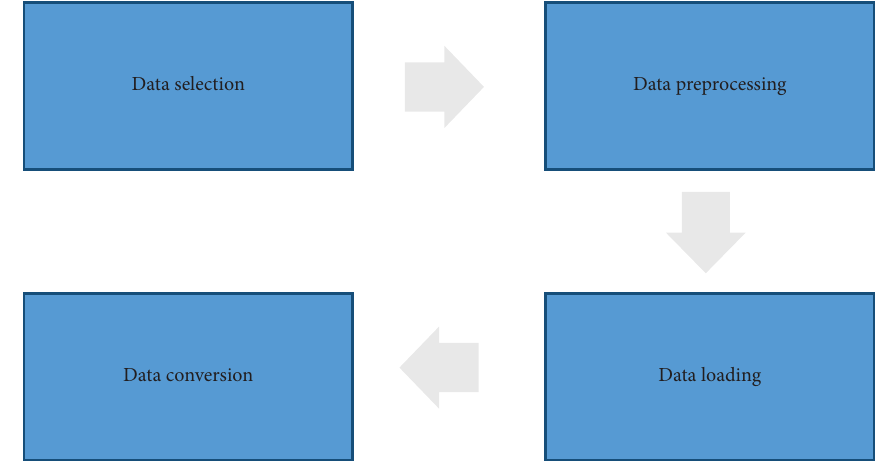
Figure 6: Steps of data preparation.